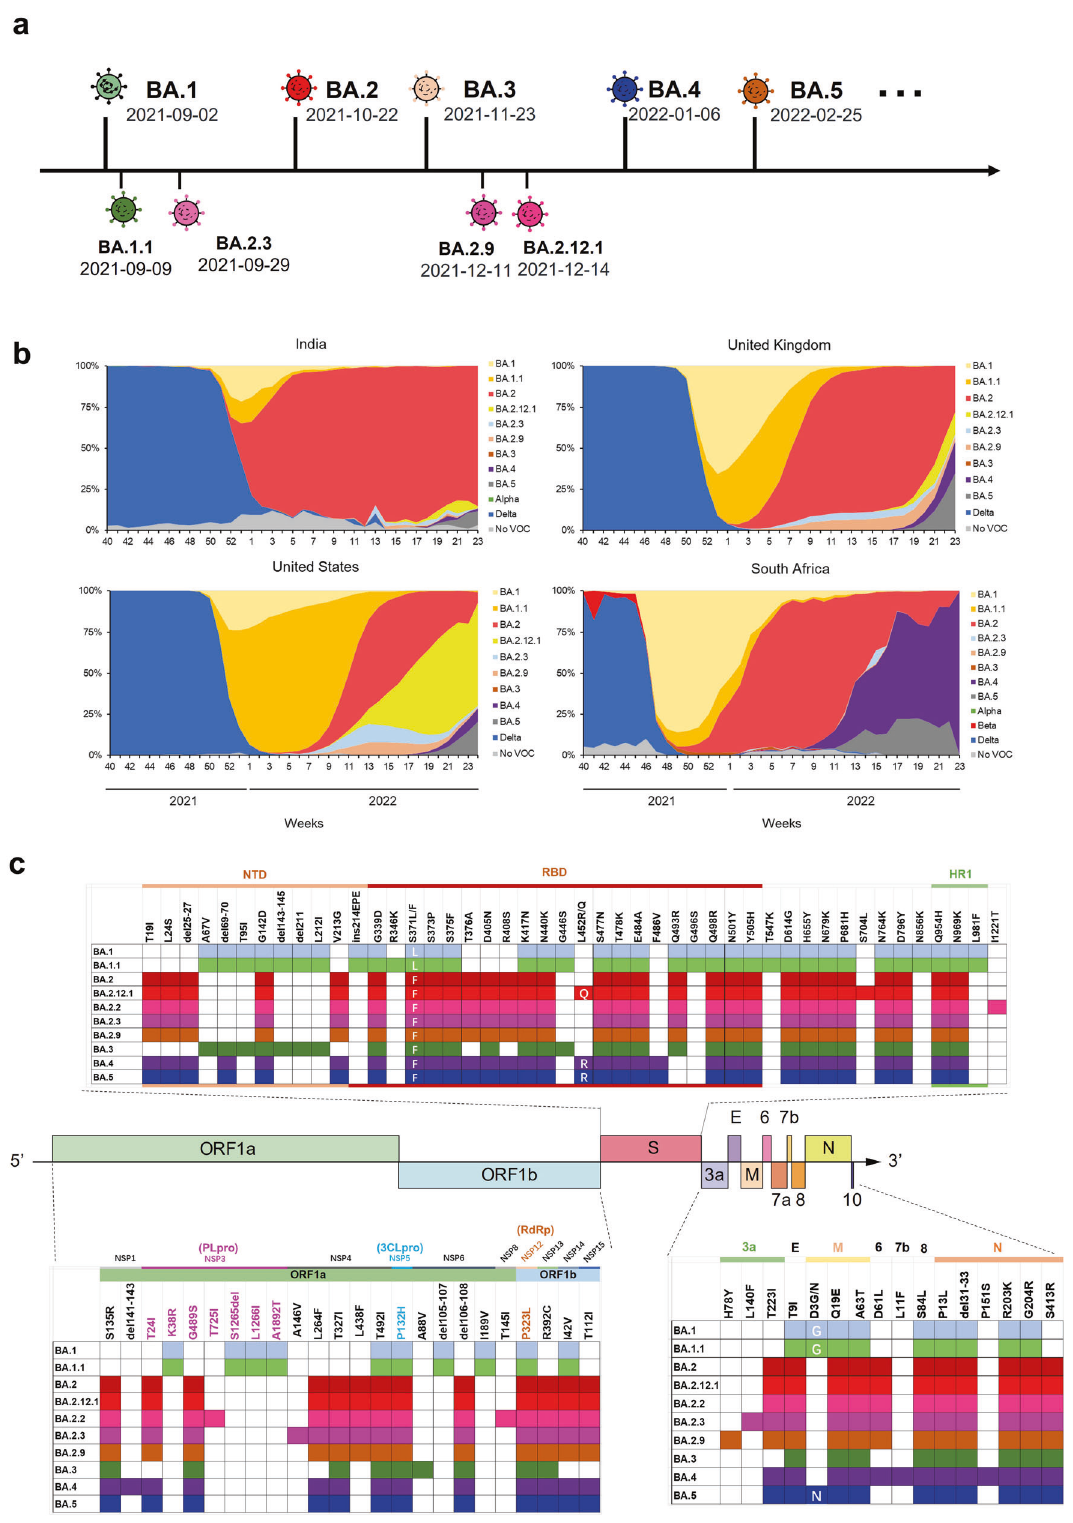
Fig. 1 Emergence and spread of Omicron sublineages. a Emerging timeline for Omicron sublineages. Earliest date for each sublineage is from cov-lineages.org (continuously updated). 2 b Prevalence of Omicron sublineages and other variants in India, the United Kingdom, the United States, and South Africa based on all sequences available on GISAID over the past 6 months. c Schematic representation of the genomic domains of SARS-CoV-2 with mutations in Omicron sublineages. PLpro (NSP3), papain-like protease; 3CLpro (NSP5), 3C-like protease; RdRp (NSP12), RNA-dependent RNA polymerase